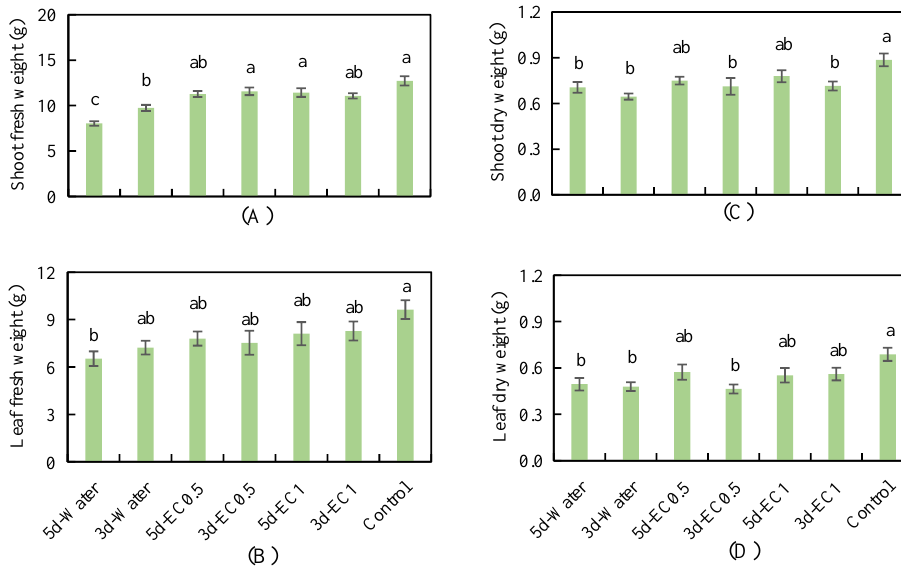
Figure 4. Shoot fresh weight ( A ), leaf fresh weight ( B ), shoot dry weight ( C ), and leaf dry weight ( D ) of basil plants under different short-term EC treatments at 34 days after sowing. The error bars represent SEs ( n = 12). Different lowercase letters represent significant differences among different EC treatments based on Tukey’s new multiple range test at p < 0.05.